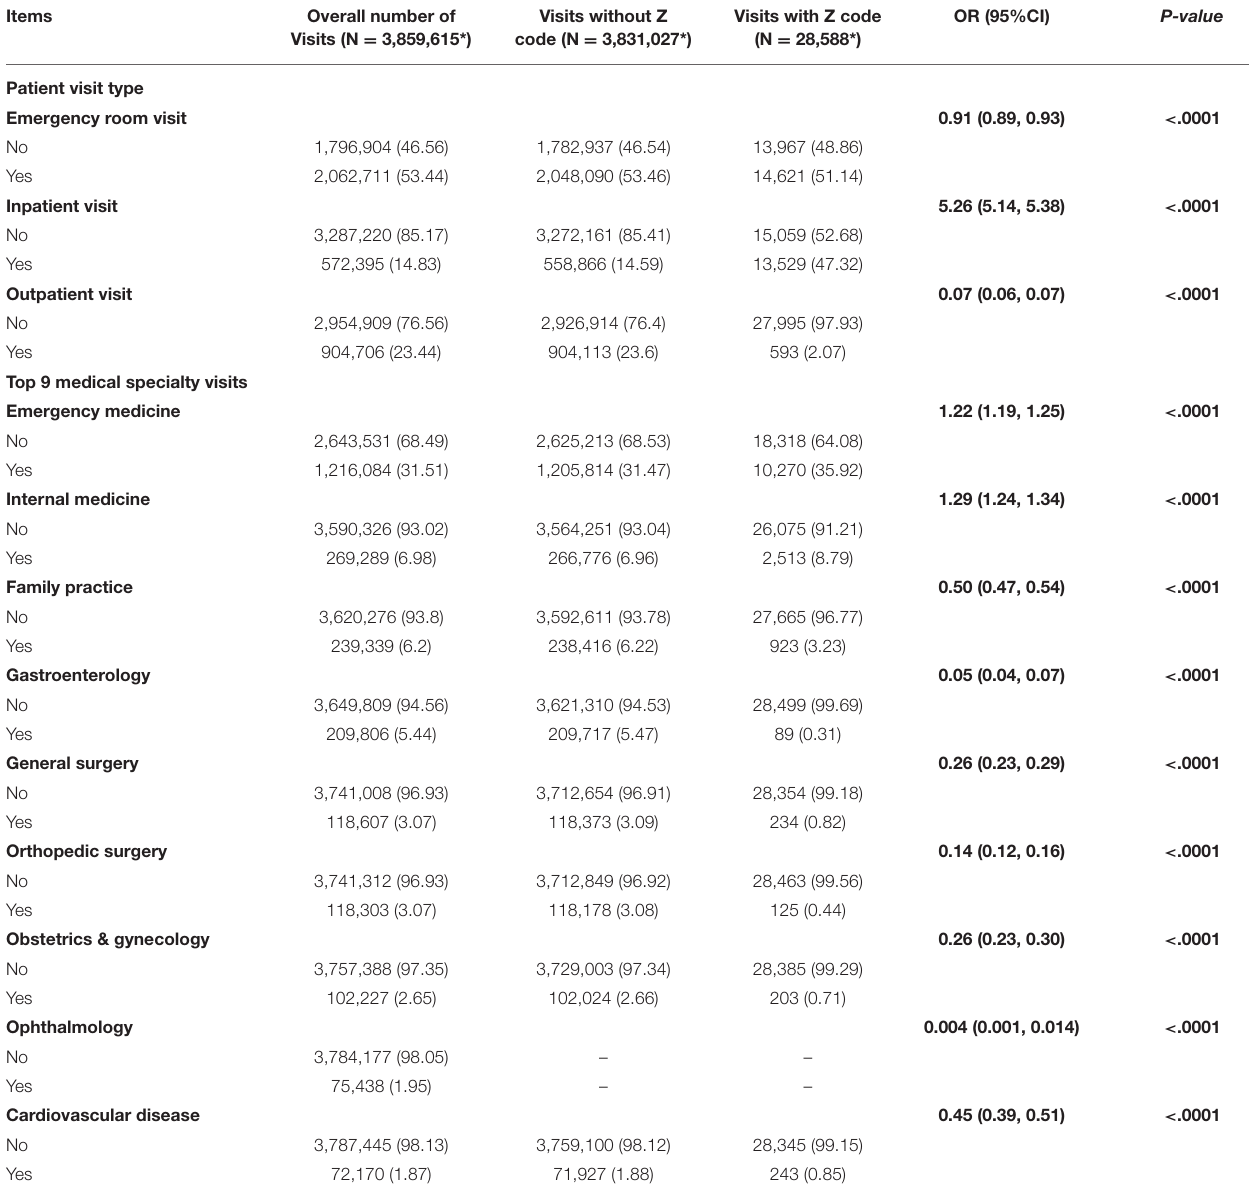
TABLE 4 | Distribution of Z codes utilization by type of patient visit and medical specialty. Items Overall number of